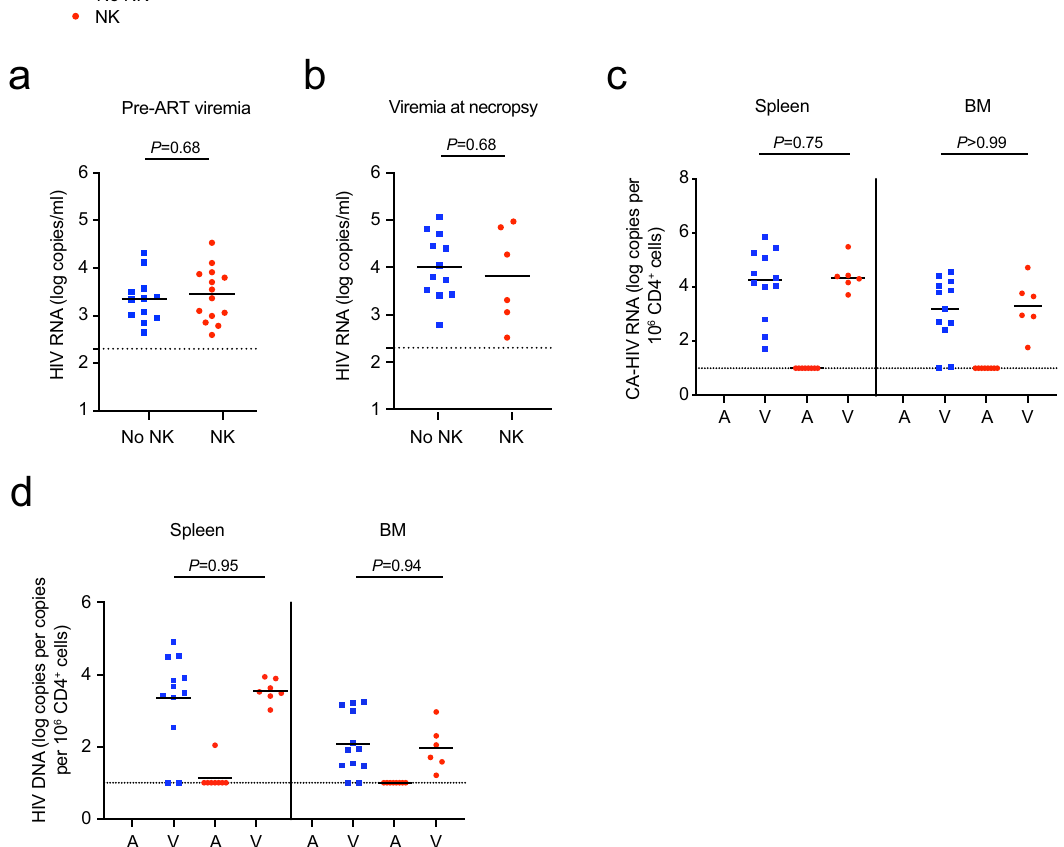
Fig. 3 Viral RNA and DNA levels in NL-HABC-infected BLT mice treated with NK cells. a Plasma viral RNA levels for each animal before ART was initiated in the No NK (blue) and NK (red) groups. b Plasma viral load at necropsy of the animals that rebounded after ART interruption. c , d Cell- associated HIV RNA ( c ) or DNA ( d ) is shown from the spleen and bone marrow “ BM ” of mice that were aviremic “ A ” or had rebound viremia “ V ” at necropsy. n = 12 biologically independent animals in the No NK group, n = 14 biologically independent animals in the NK group ( a , c , d ). Among the rebounding animals, n = 12 biologically independent animals in the No NK group, n = 6 biologically independent animals in the NK group ( b ). The black dotted line indicates the detection limit of 2.3 log RNA copies per ml ( a , b ) or 1.0 log RNA or DNA copies ( c , d ). Horizontal bars represent the means. P values were calculated using the two-tailed Mann-Whitney test. Source data are provided as a Source Data fi